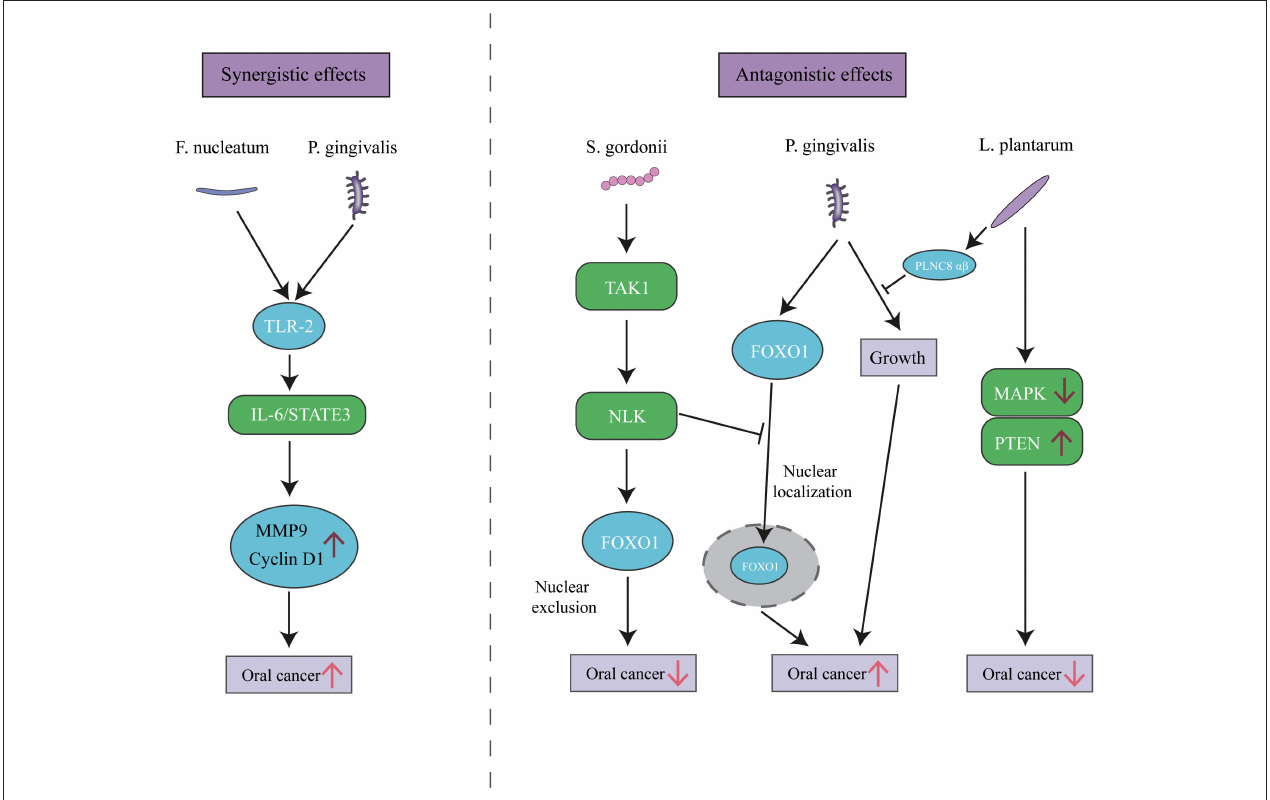
FIGURE 3 | The synergistic and antagonistic effects among oral bacteria in oral cancer. P. gingivalis and F. nucleatum triggers TLR signaling, resulting in IL-6 production that activates STAT3 which in turn induces oral cancer growth and invasiveness. P. gingivalis can localize FOXO1 in nuclear to promote oral cancer, while the presence of S. gordonii can activate the TAK1-NLK1 pathway, which supersedes the effect of P. gingivalis and translocates FOXO1 to the cytoplasm, where it is inactive. L. plantarum can inhibit oral cancer through upregulation of PTEN and downregulation of MAPK pathways, and its bacteriocin PLNC8 αβ can suppress P. gingivalis growth and subsequent